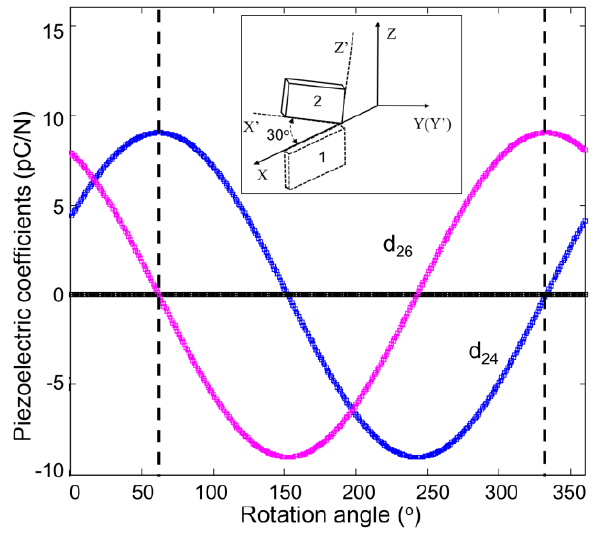
Figure 10. Thickness shear piezoelectric d rotation angle θ. The inset shows the schematic of crystal cut ( YXt